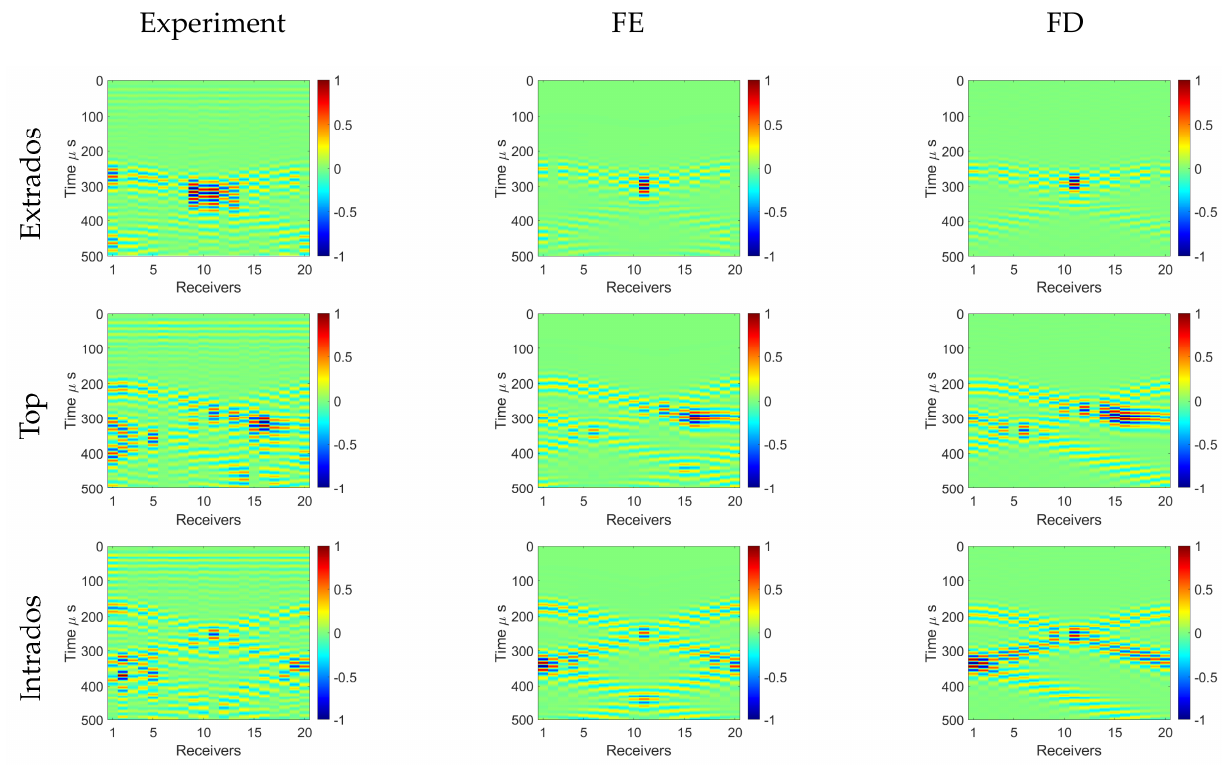
Figure 9. Experimental, FE, and FD contour plots of normalized radial displacement in the bend for three excitation positions: extrados, top, and intrados. The A 0 mode was exited with a central frequency of 50